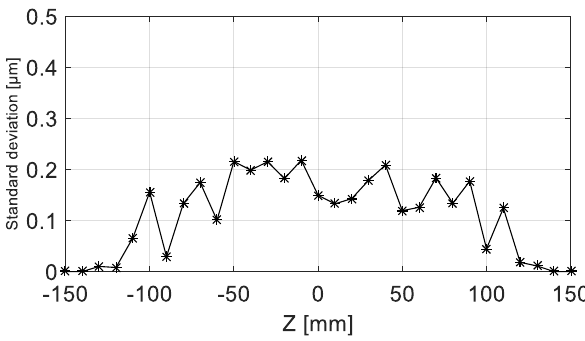
Figure 14. Plane vertical spraying: sample standard deviation of each measurement point.